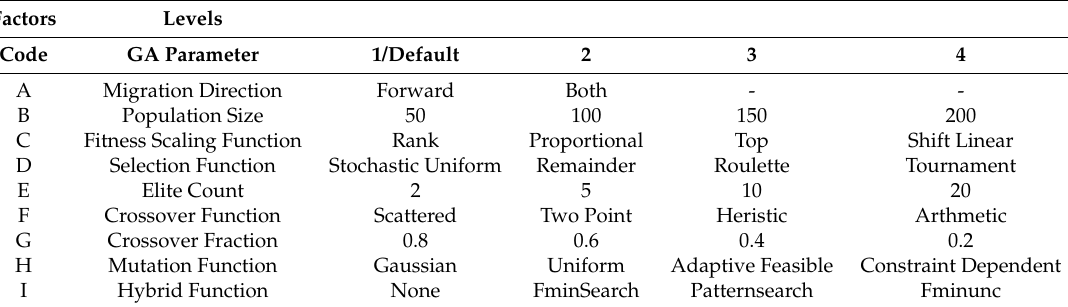
Table 1. Genetic Algorithm Parameters and their